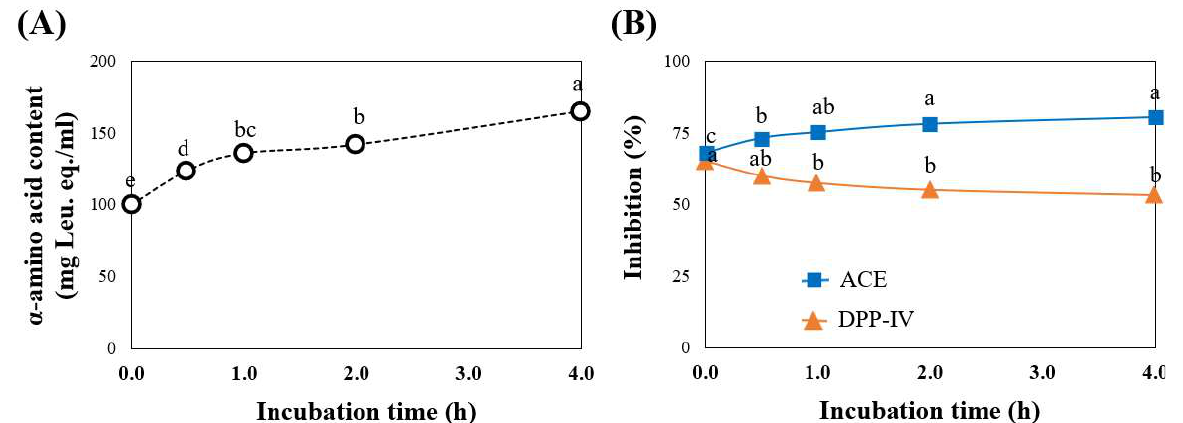
Figure 6. α-amino acid content ( A ), DPP-IV, and ACE inhibitor activities of UF3 incubated with human plasmin from different hydrolysis times (0–4 h) ( B ). The DPP-IV and ACE inhibitory activities were measured at final concentrations of 10 mg and 50 µg Leu equivalents/mL, respectively. Significantly different values within the line ( p < 0.05) are represented by superscript letters (a–e).